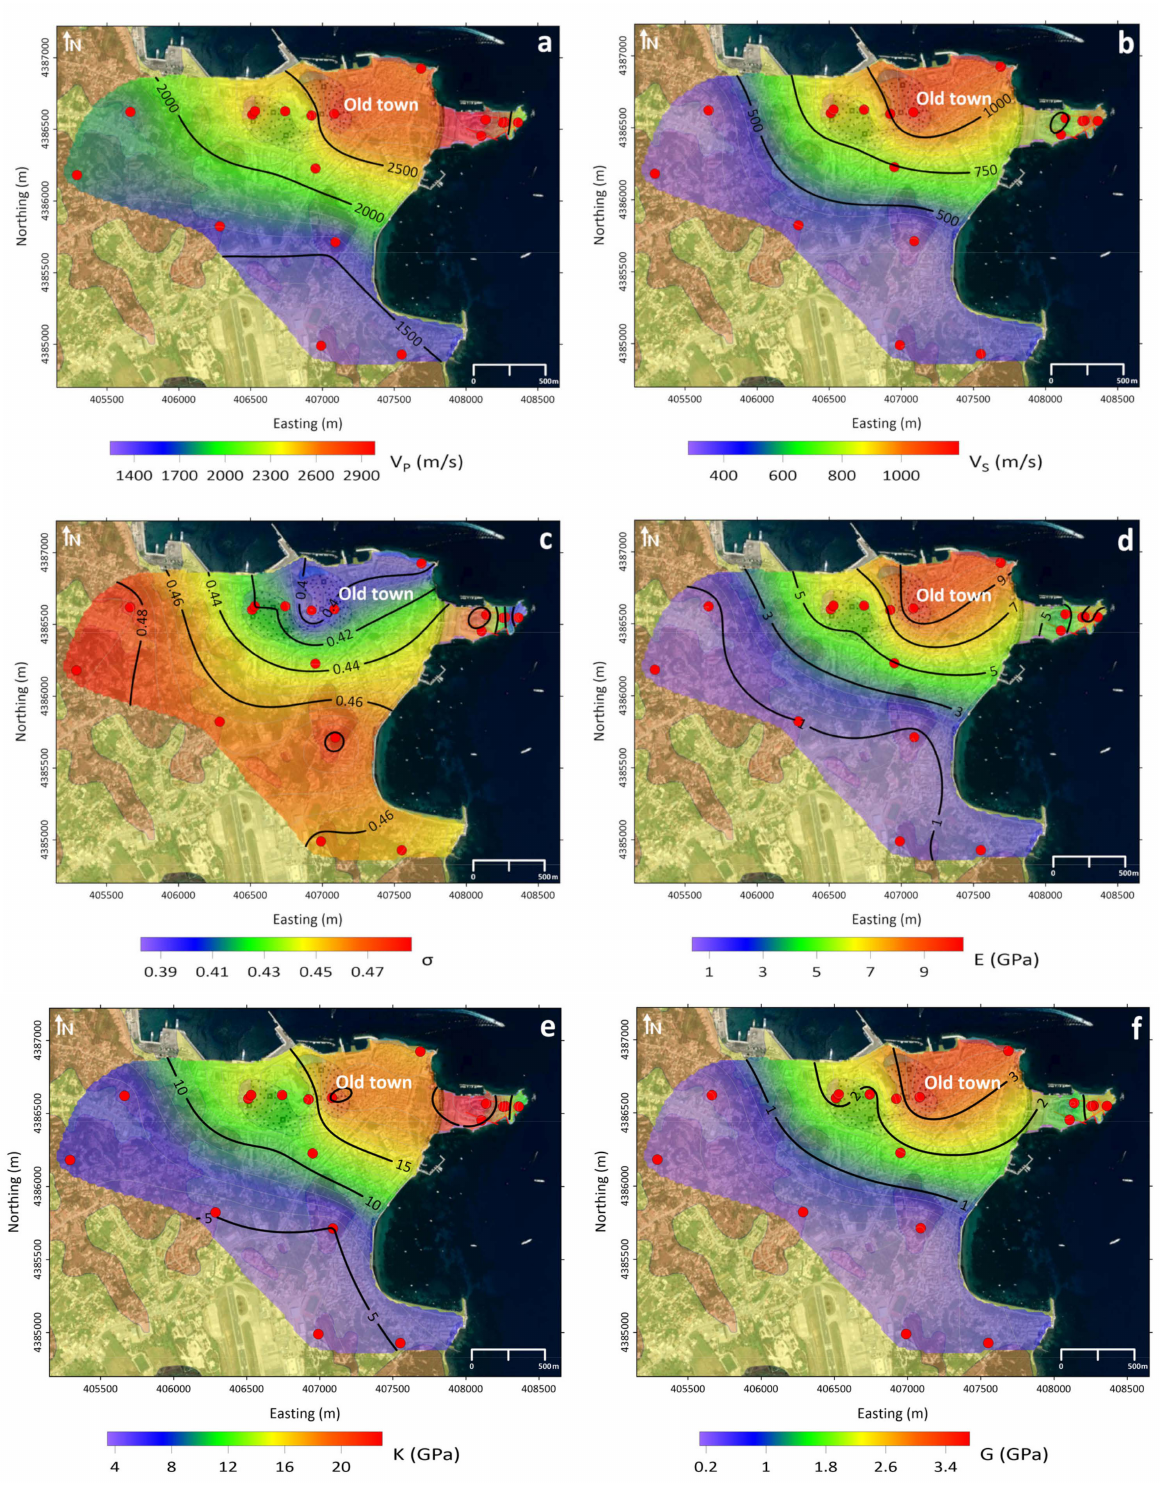
(Figure 9b), Poisson’s ratio ( σ ) (Figure 9c), Young’s modulus ( E ) (Figure 9d), bulk modulus ( K ) (Figure 9e) and shear modulus ( G ) (Figure 9f).